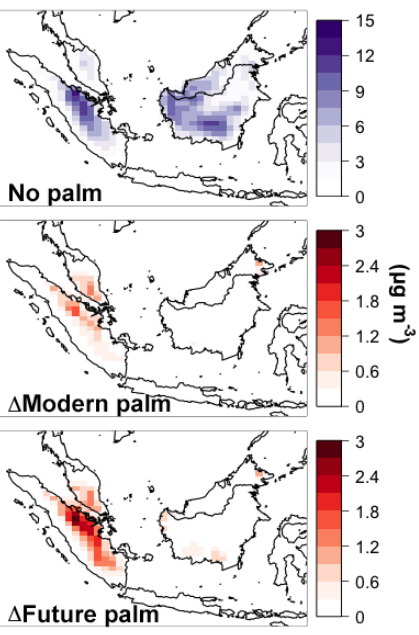
Figure 12. Annual average surface biogenic secondary organic aerosol (SOA) concentrations over SEA (top) and the change due to Modern (middle) and Future (bottom) Palm expansion.